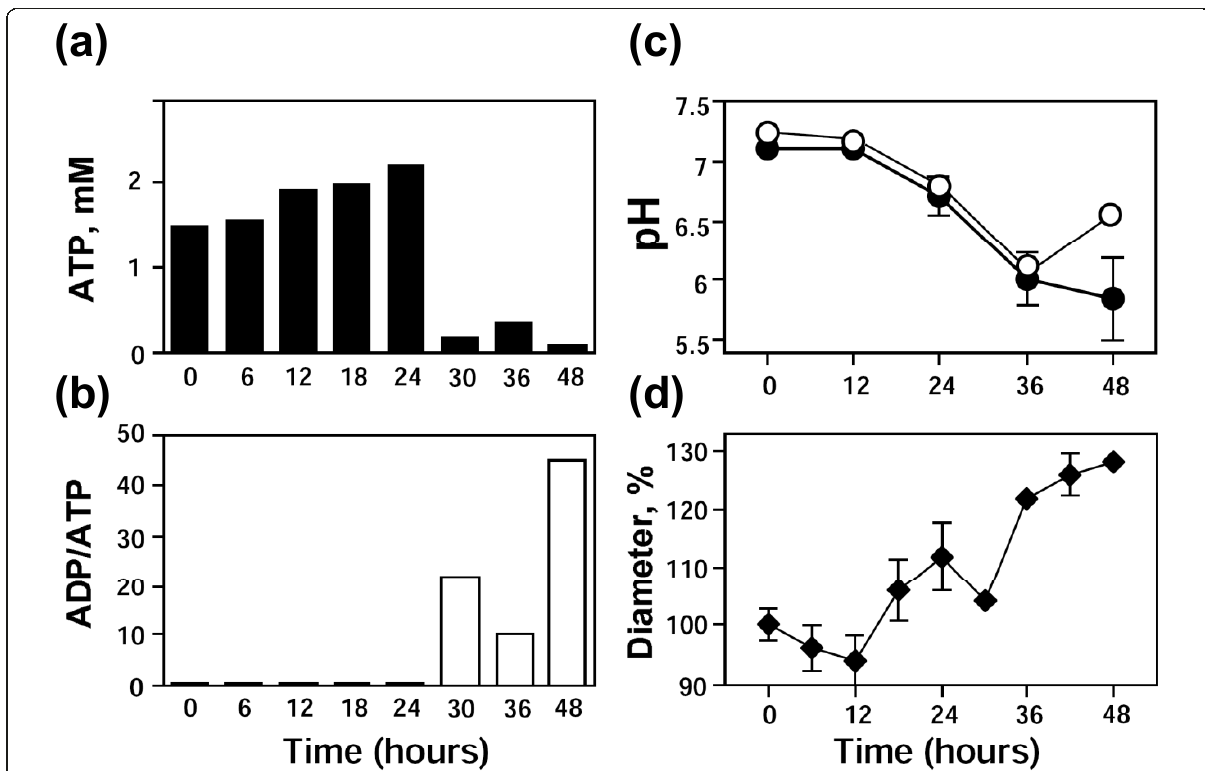
Figure 3 Cell death events in unfertilized Xenopus eggs . Intracellular ATP content (a) , ADP/ATP ratio (b) , intracellular pH (c) , and egg diameter (d) were monitored over 48 hours after ovulation. Intracellular pH in panel (c) was measured using spectrometric and fluorescent assays (closed and open circles, respectively). Bars in panel (c) represent the range of pH readings taken by two persons in double-blind trials and data in panel (d) are means ± SD obtained by measurement of five eggs.